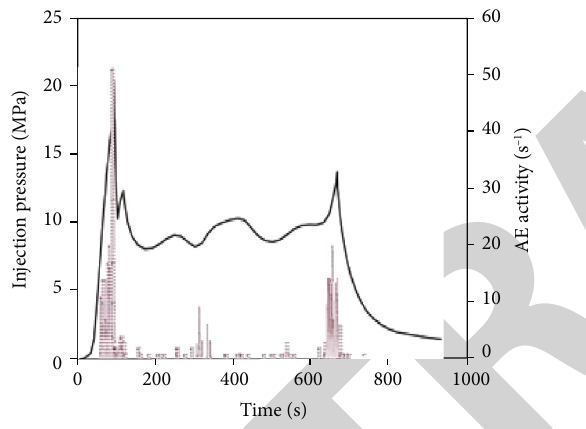
Figure 12: The injection pressure curve and AE activity of Sample